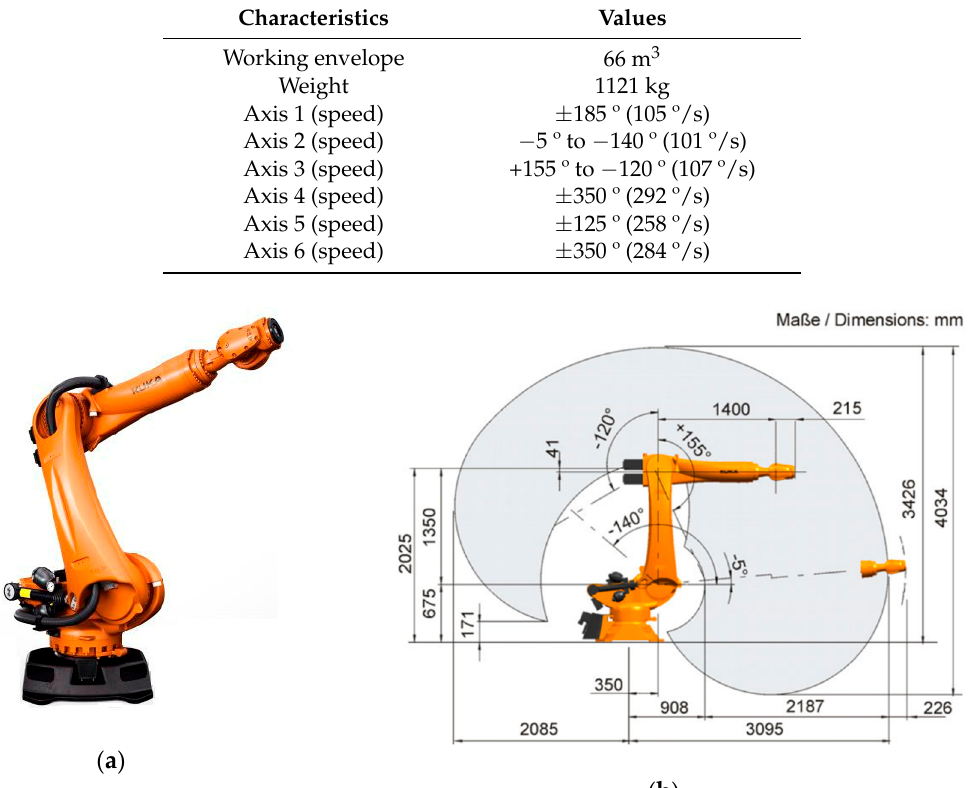
Figure 10. KUKA KR90 R3100 robot: ( a ) General aspect of the robotic arm manipulator; ( b ) Working envelope with dimensions comprised during operation. Images obtained from [23].